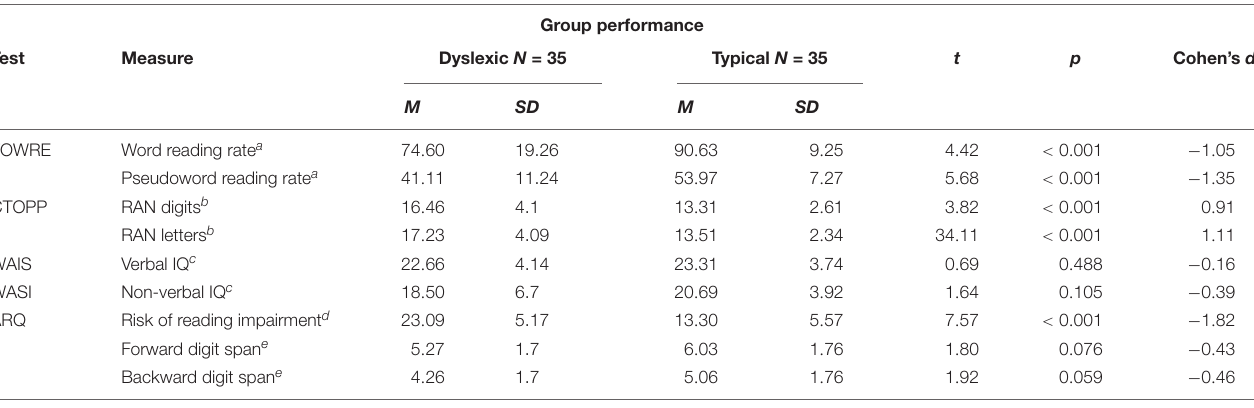
TABLE 1 | Group scores on literacy and general cognitive ability measures.